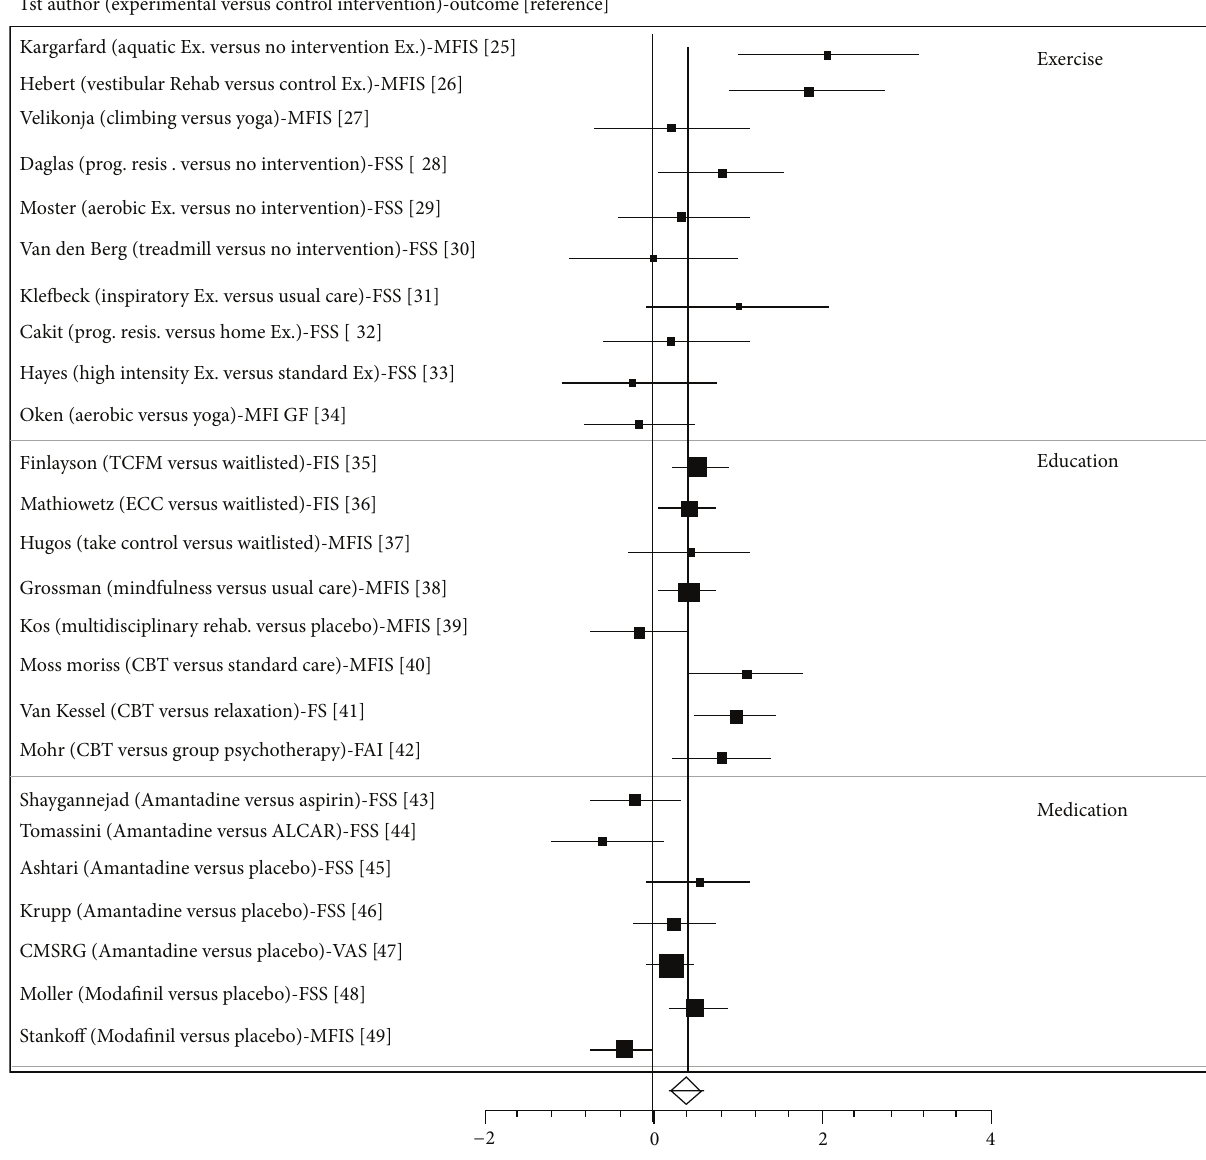
Figure 2: Forest